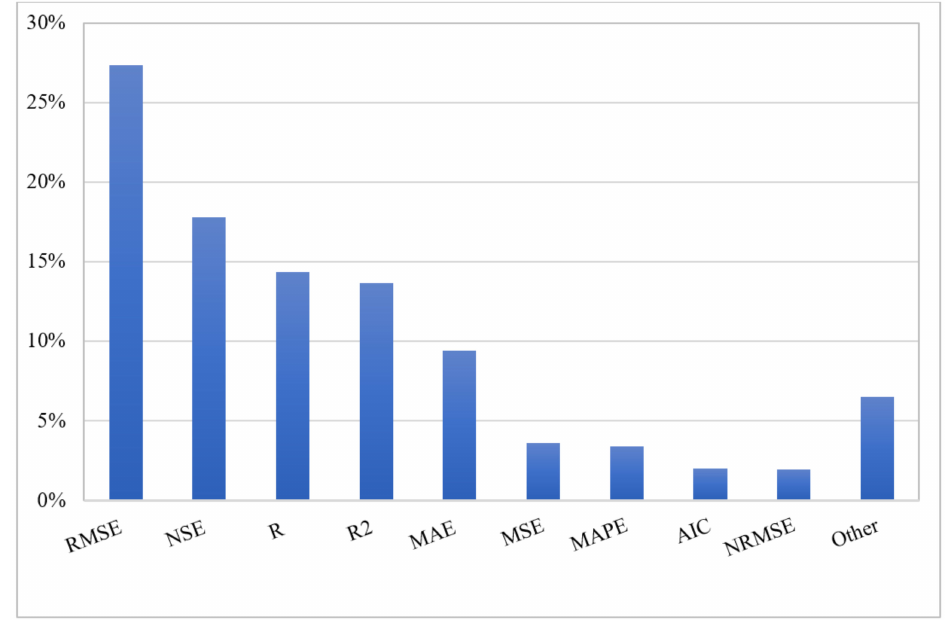
Figure 10. The proportion of employed quantitative measures of